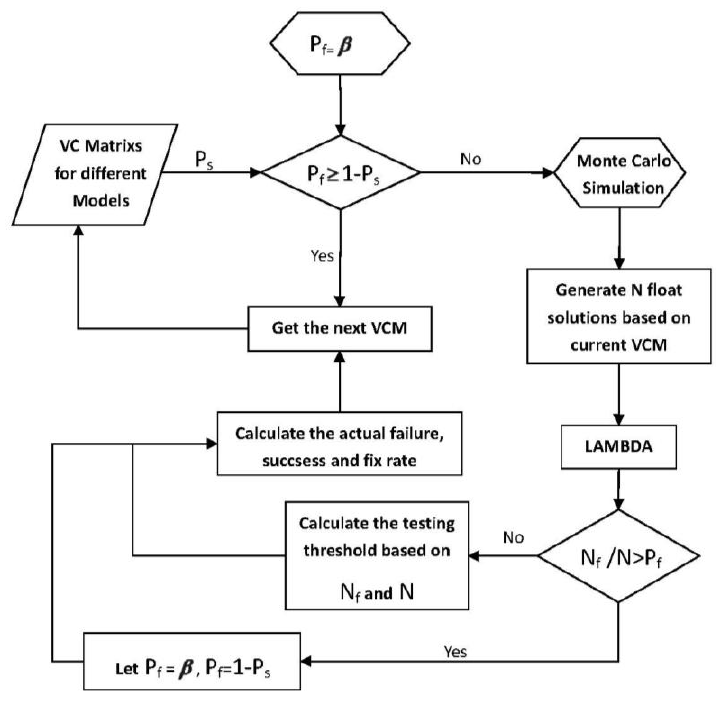
Figure 5. Determination of the testing threshold in the framework of integer aperture estimator with fixed failure rate.